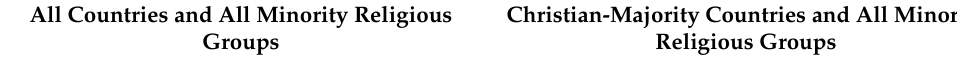
Table 2. Negative binomial regression predicting the relationship between societal discrimination of religious minority groups and country characteristics—all religious minority groups.